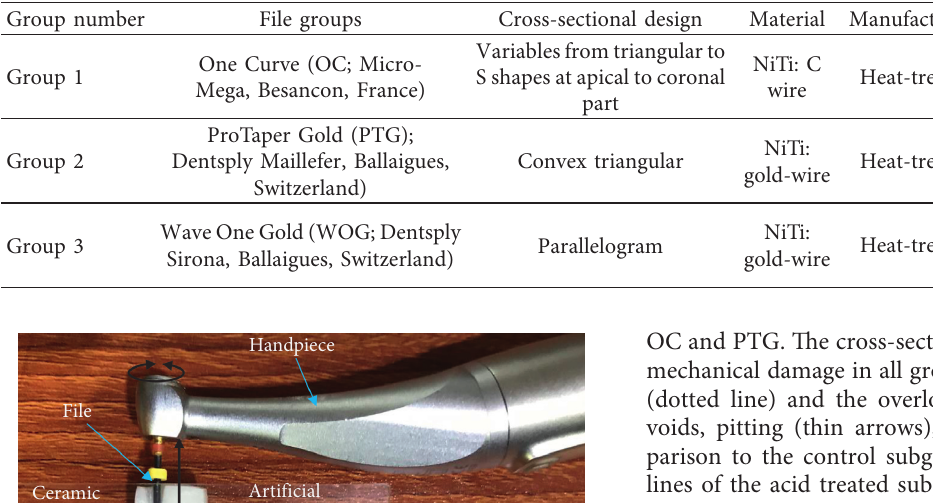
Table 1: Instrument groupings and their characteristics.